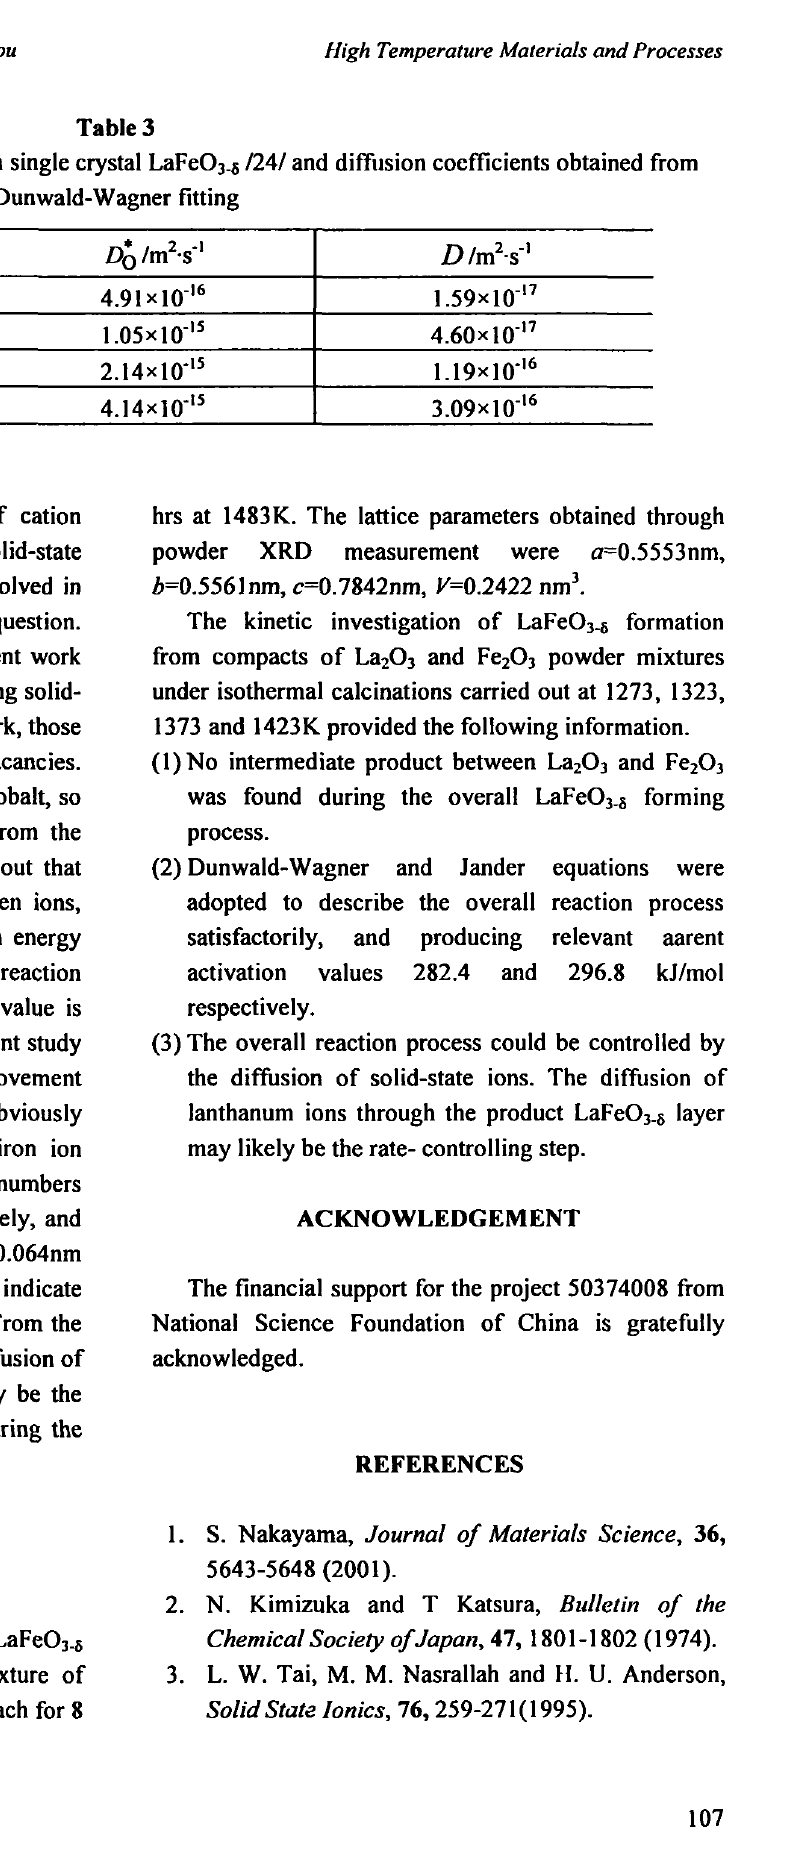
Tracer diffusion coefficients of oxygen ions in single crystal LaFeO